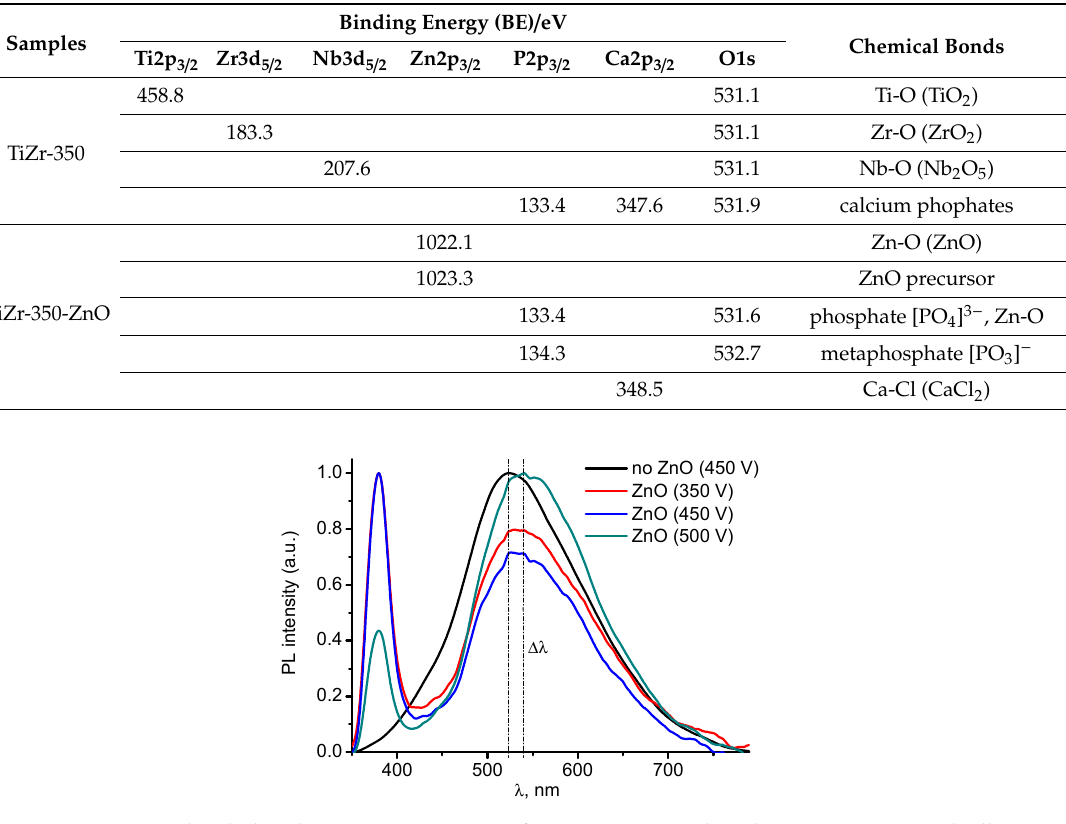
Figure 7. Normalized photoluminescence spectra of ZnO-incorporated oxide coatings on TiZrNb alloy.